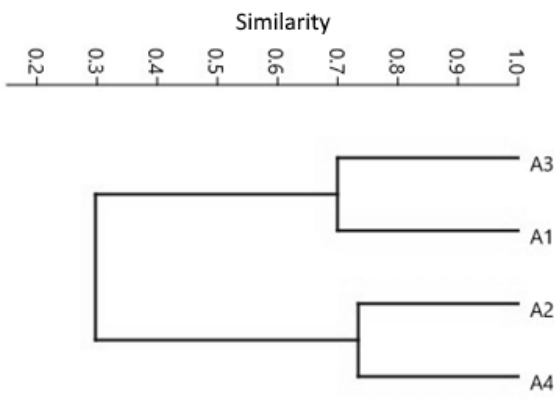
Figure 4 . Similarity (Morisita-Horn index) between the studied areas in the period between September 2012 to November 2013 in the Baturité Massif, State of Ceará,